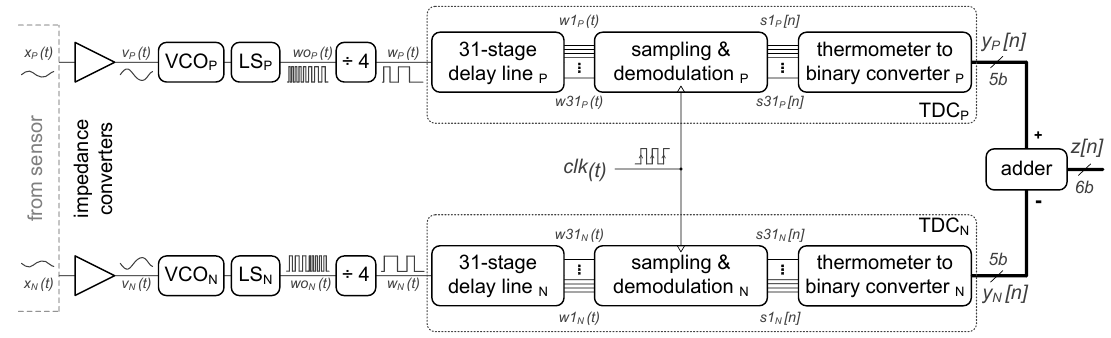
Figure 2. Architecture of the proposed pseudo-differential voltage-controlled oscillator (VCO)-based analog-to-digital converter